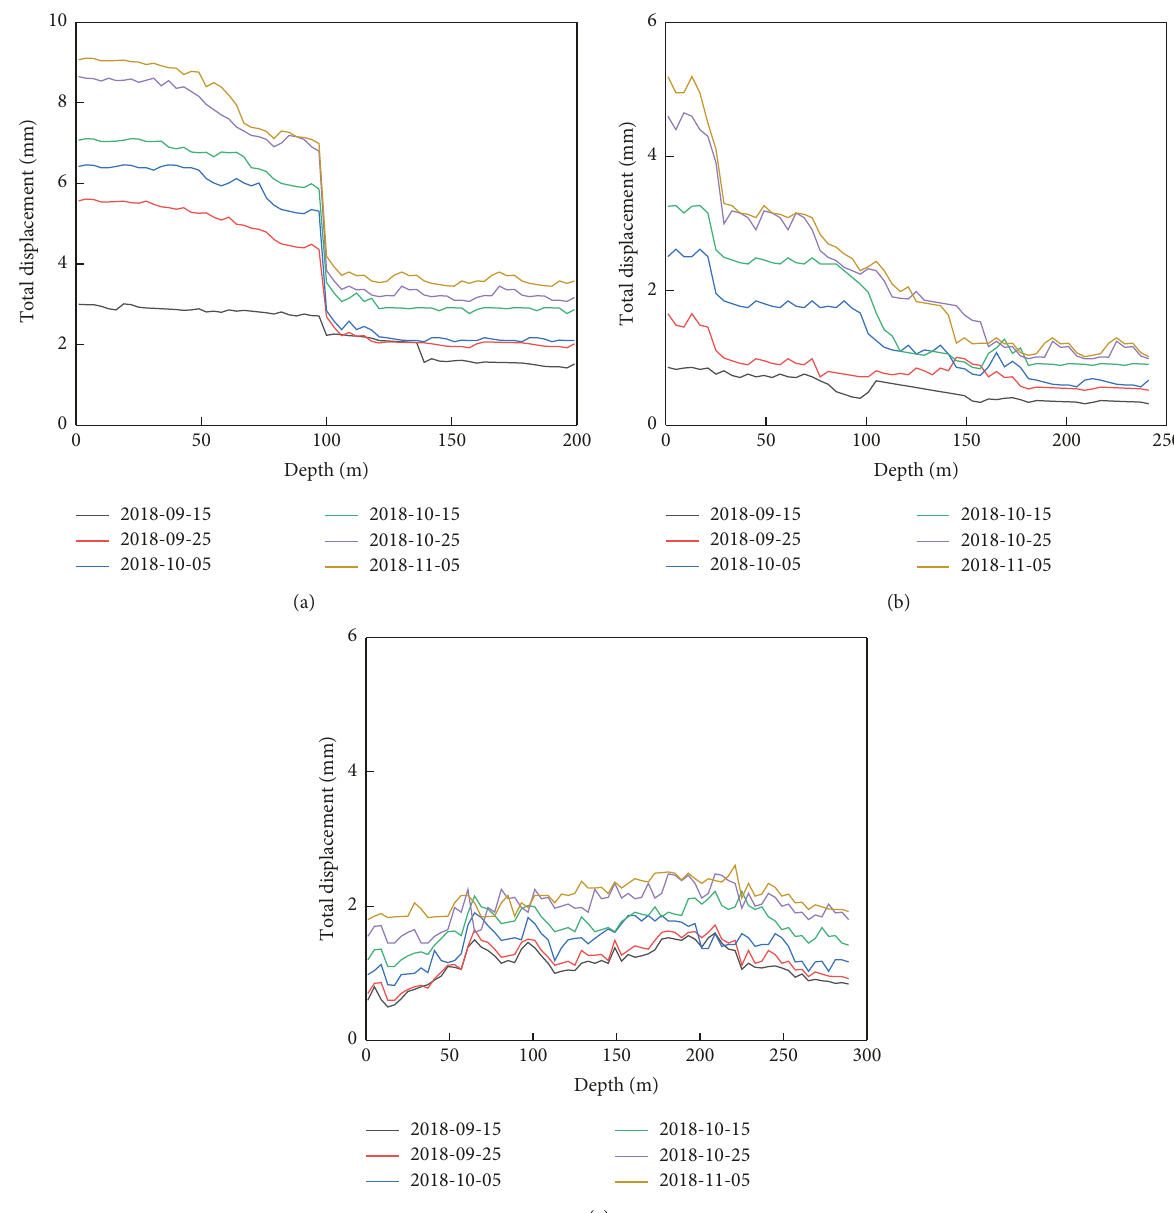
Figure 8: Cumulative displacements of the monitoring point in surveying the inclined hole: (a) surveying inclined hole 69002; (b) surveying inclined hole 55026; (c) surveying inclined hole